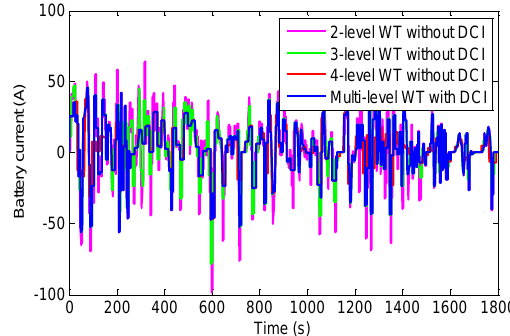
Figure 26. Current comparison of battery bank. WT, wavelet transform; DCI, driving cycle identification.